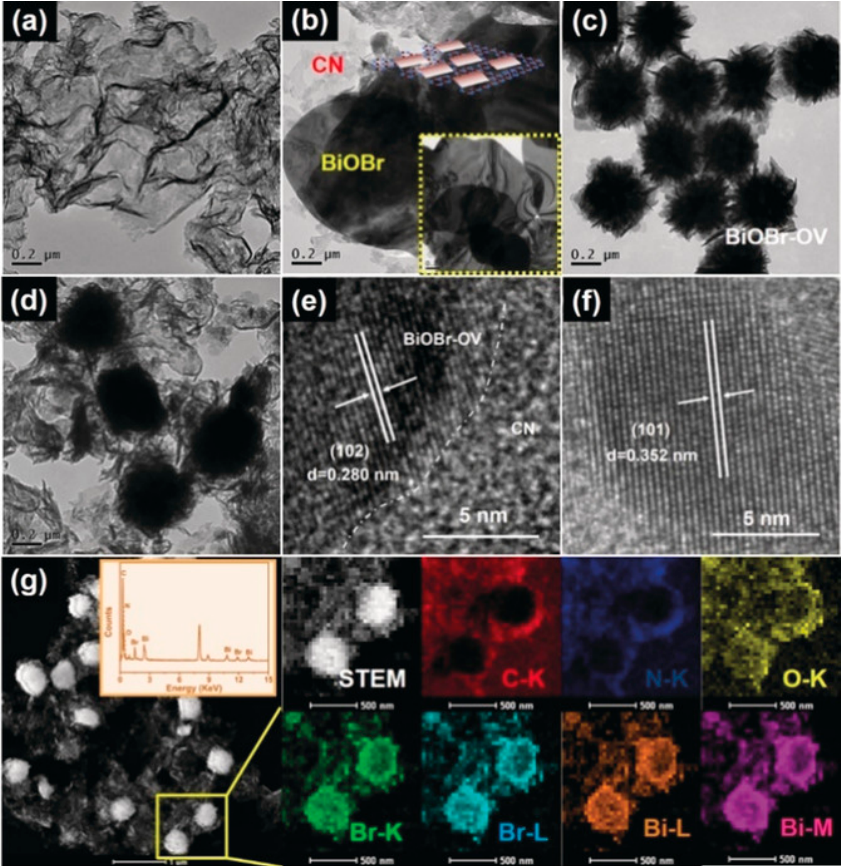
Figure 10. TEM micrographs of ( a ) pristine g-C 3 N 4 , ( b ) defect free-BiOBr/g-C 3 N 4 , ( c ) pristine BiOBr enriched with oxygen vacancies, ( d ) oxygen vacancy enriched BiOBr/g-C 3 N 4 , ( e , f ) HRTEM micrographs of oxygen vacancy enriched BiOBr/g-C 3 N 4 depicting the lattice spacing and ( g ) the corresponding elemental maps of C, N, O, Br and Bi. Reprinted from Ref. [218] with permission from Wiley-VCH.